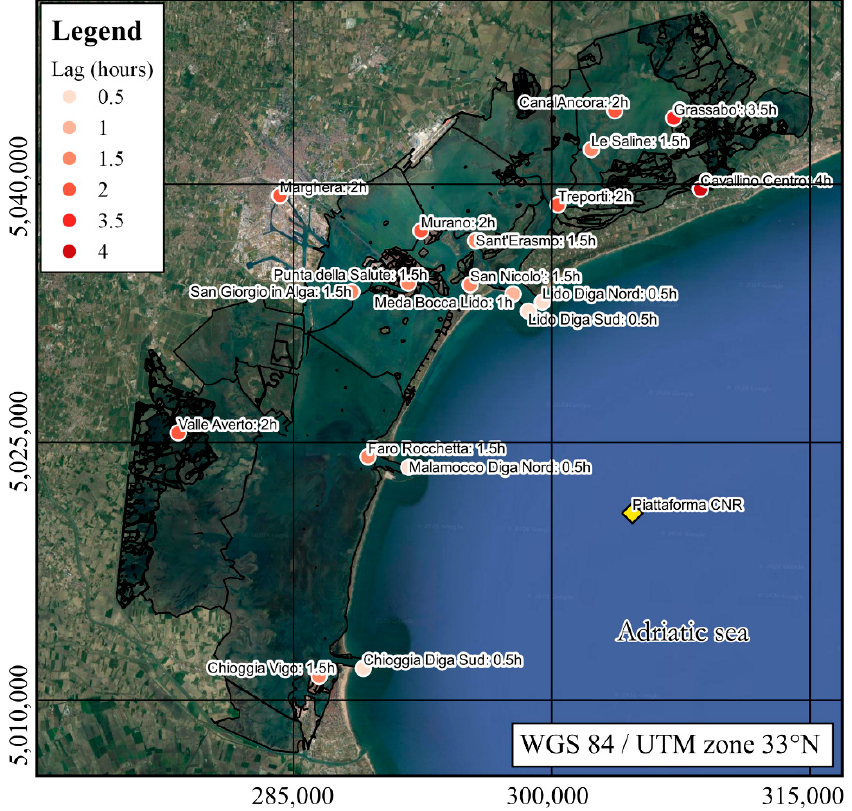
Figure 6. Scattered map of the lag times t d,c . Table 3. Lag times and cross-correlation peaks.